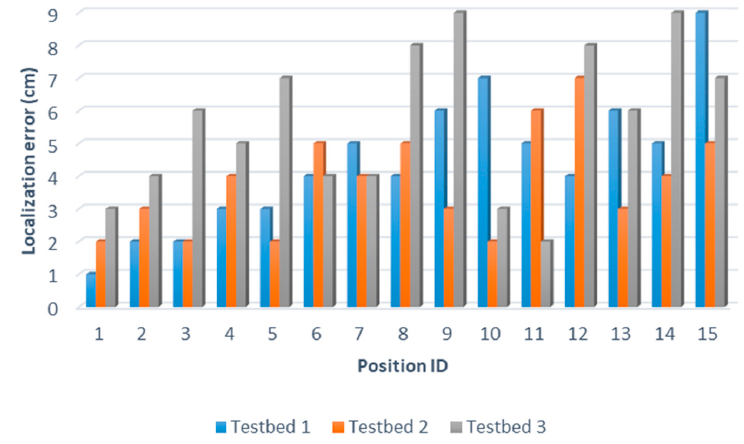
Figure 15. The localization error using the MWFS approach for 3 different testbeds.